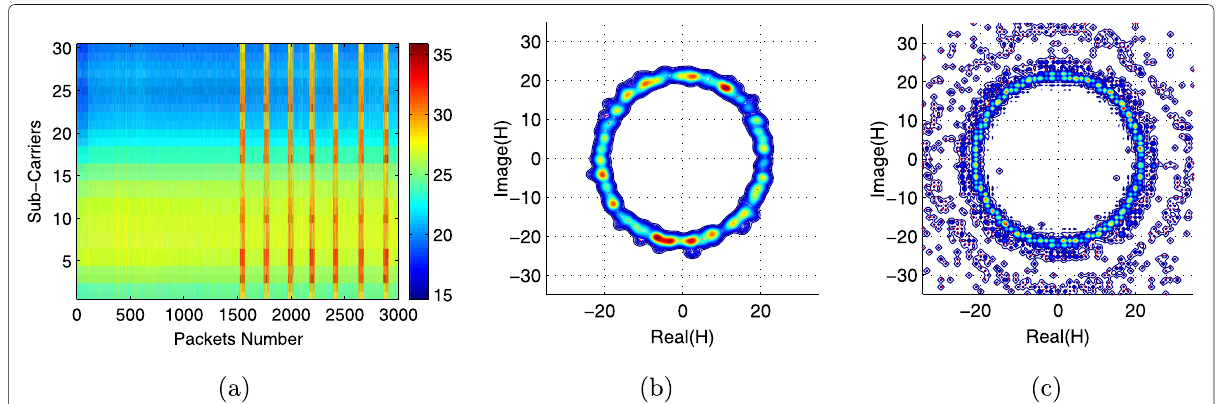
Fig. 2 a CSI amplitude graph of 3000 received frames including frames injected by an attack. b and c CSI distribution I/Q view for the 20th subcarrier of the first and second half of the frames,